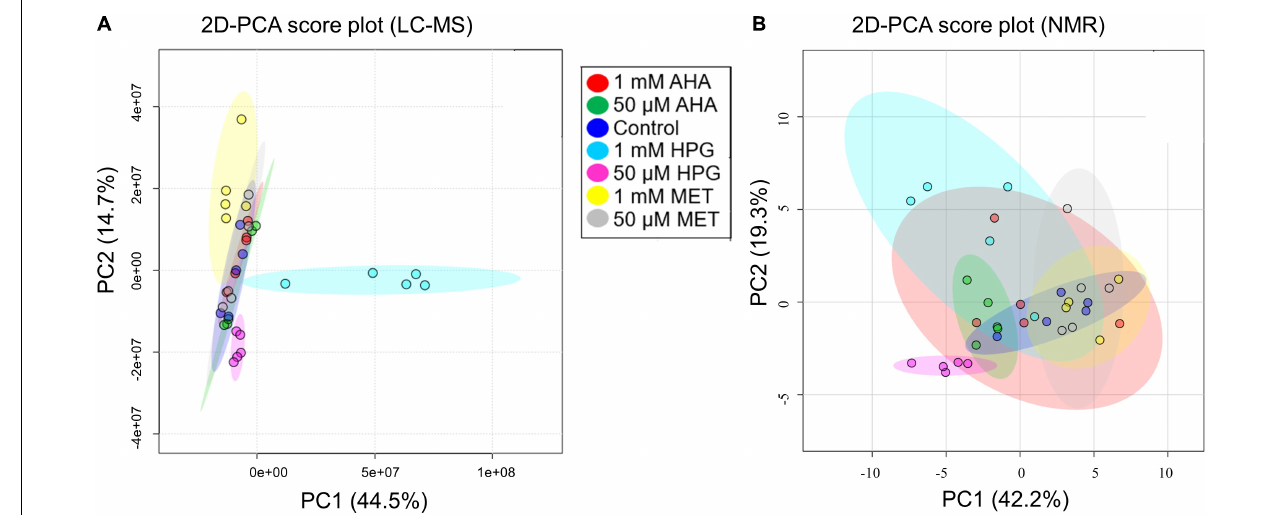
FIGURE 1 | 2D-PCA plots of all experimental conditions from E. coli NCAA experiment. (A) MS data and (B) NMR data are shown. (A) The PCA plot of the MS data shows that only cultures grown with 1 mM HPG separate from the other experiment conditions. (B) The NMR data show significant overlap and a lack of differentiation between experimental groups, the only exception being the group with 50 µ M HPG.